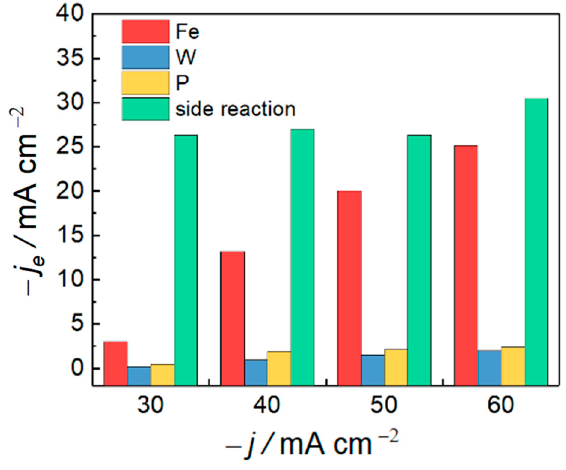
Figure 4. Partial deposition current densities j e of the elements Fe, W, P, and the hydrogen evolution (side reaction), j vs. the applied current densities. pH 3.